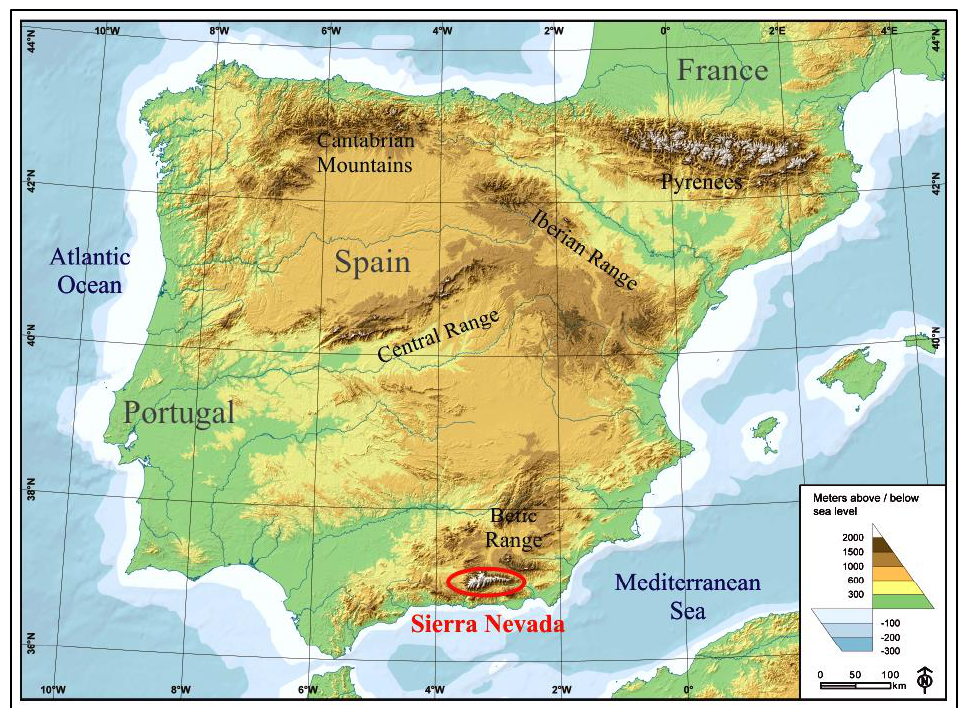
Figure 1. Physical map of the Iberian Peninsula and the location of Sierra Nevada (Corral del Veleta rock glacier).